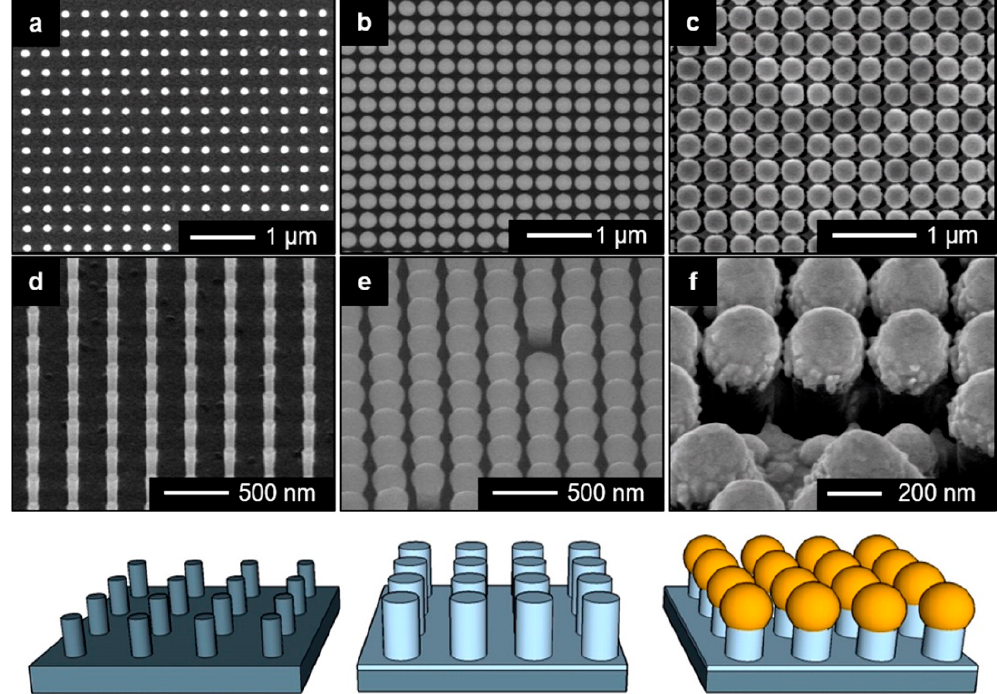
Figure 37. SEM images of the SERS substrates at different fabrication stages. ( a ) Silicon nanopillars fabricated after lithography and etching; ( b ) nanopillars after silica deposition; ( c ) nanopillars after gold deposition. Images in panels ( d – f ) are taken at a 45° angle and are enlarged with respect to images in panels ( a – c ), respectively. Reproduced with permission from Kanipe et al. [355]. Copyright (2016), the American Chemical Society.